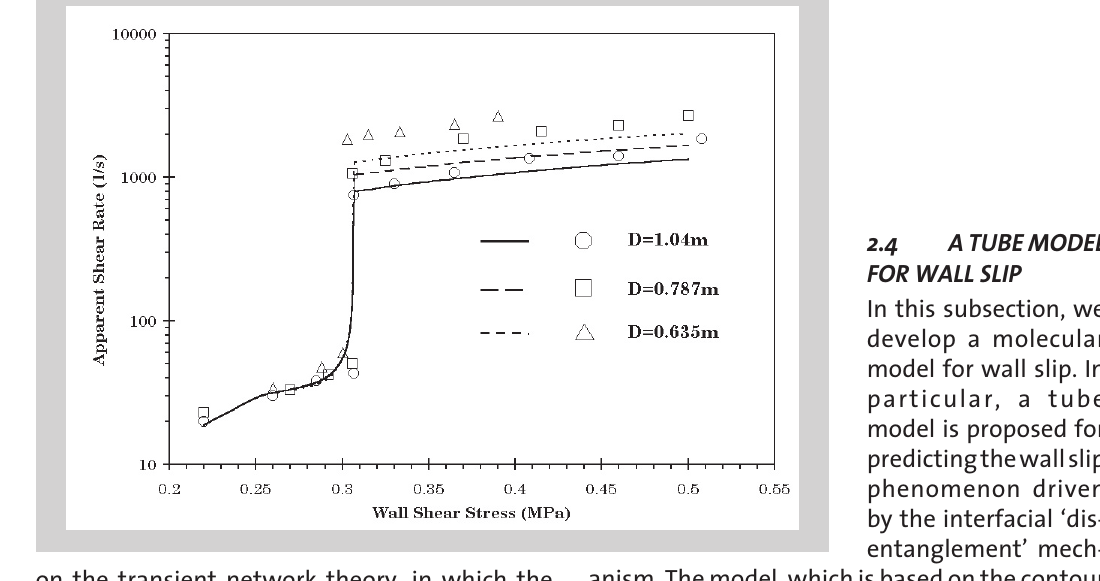
Figure 1: Comparison of model prediction for apparent shear rate vs. wall shear stress with polyethylene melt experimental data [12]. Flow curve for D = 1.04 mm is fitted using model parameters while the flow curves for other diameters are predictions. Points represent experimental data and line represents model fit.